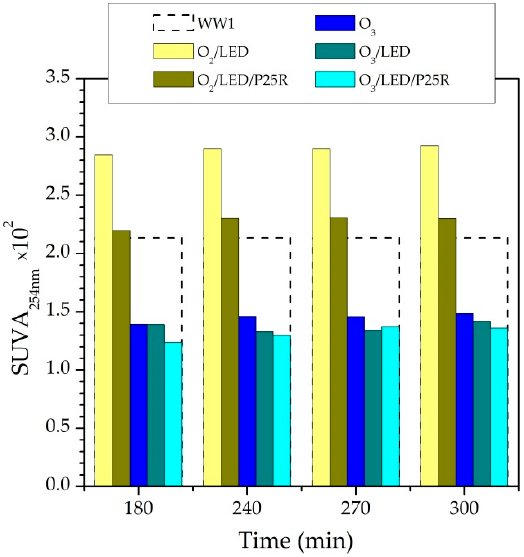
Figure 3. SUVA (specific ultraviolet absorbance) values at 254 nm reached with each oxidation process after different times once the steady state situation was achieved. Conditions: Hydraulic retention time (HRT) = 39 min; recirculation ratio = 9:10; gas flow rate = 150 mL·min − 1 ; ozone gas concentration (when applied) = 20 mg·L − 1 ; P25R loading c.a. 0.29 g.